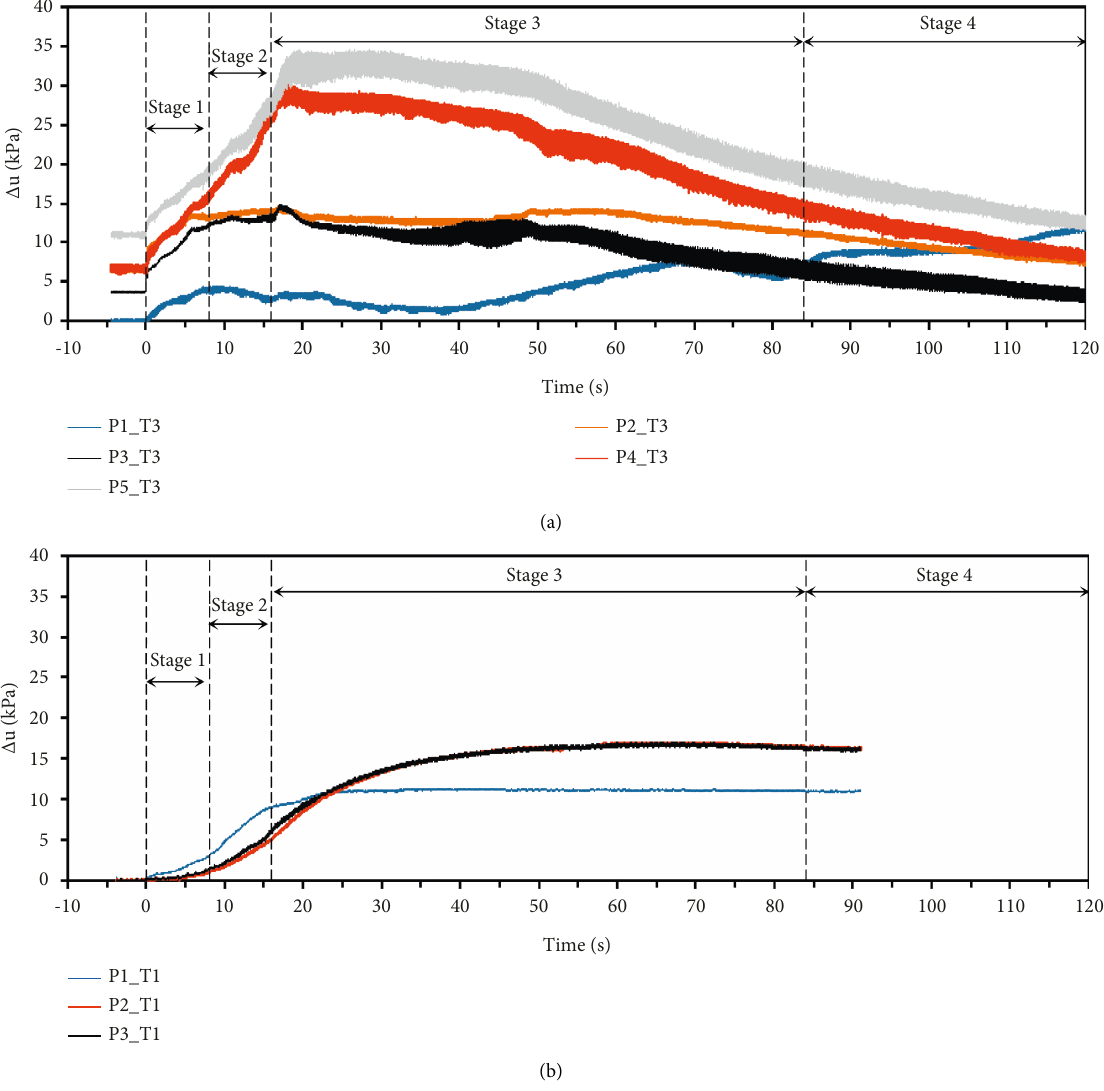
Figure 8: Evolutions of excess pore pressure with time (a) in test T 3 and (b) in test T 1 for the tailings located in the upstream